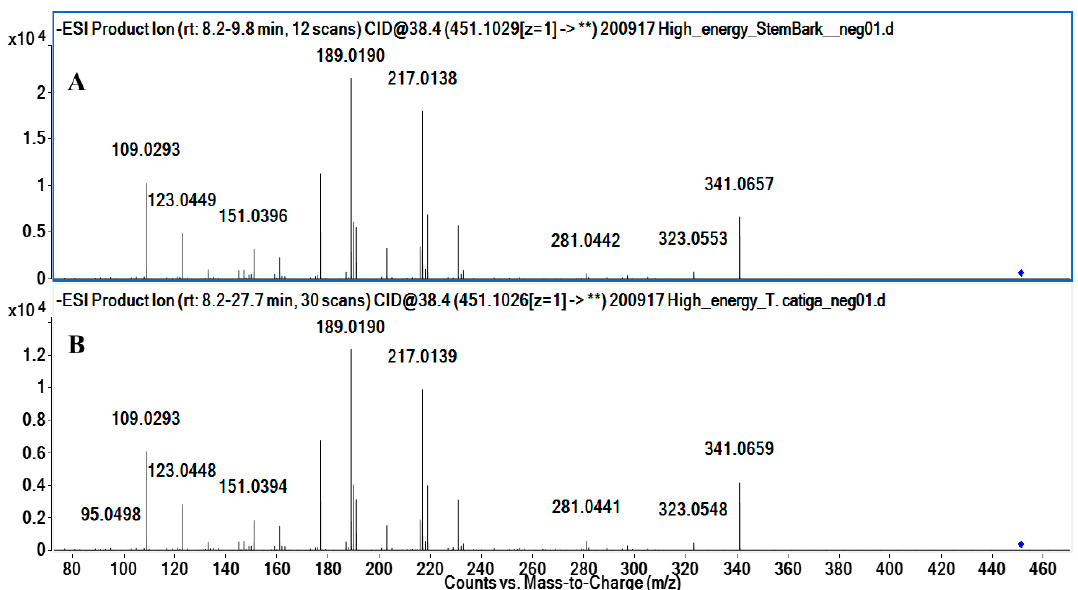
Figure 4. Extracted ion chromatogram (EIC) of [M − H] − = 451.1029 for cinchonain Ib ( 33 ) from stem bark ( A ) and the crude extract of Trichilia catigua ( B ).